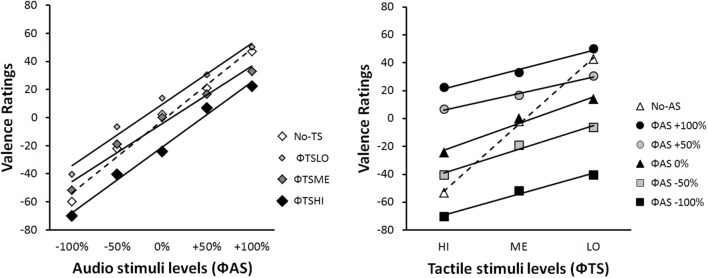
Integration graphs of mean participants’ EV responses expressed as a function of the physical scale (Φ) for each stimulus category.